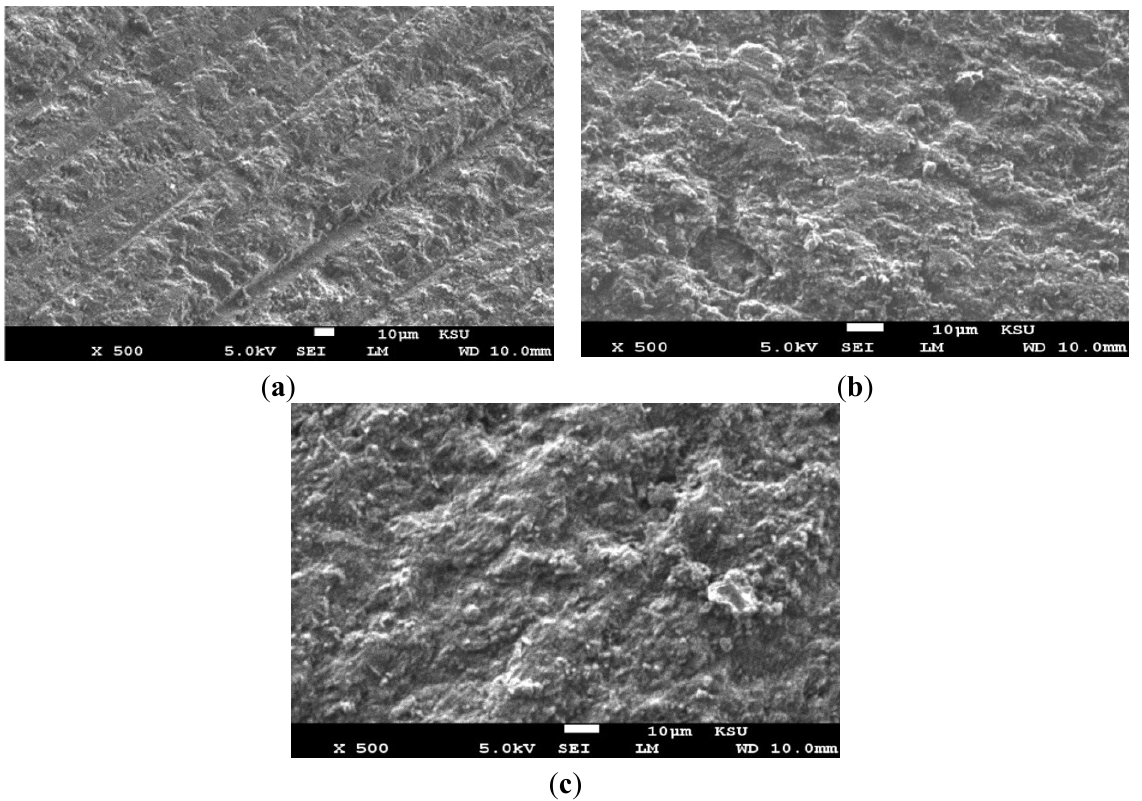
Figure 4. SEM images obtained for the surface of Al–TiC composite sintered at ( a ) 900, ( b ) 1100, and ( c ) 1300 °C after its immersion for 1 h in 3.5% NaCl solutions followed